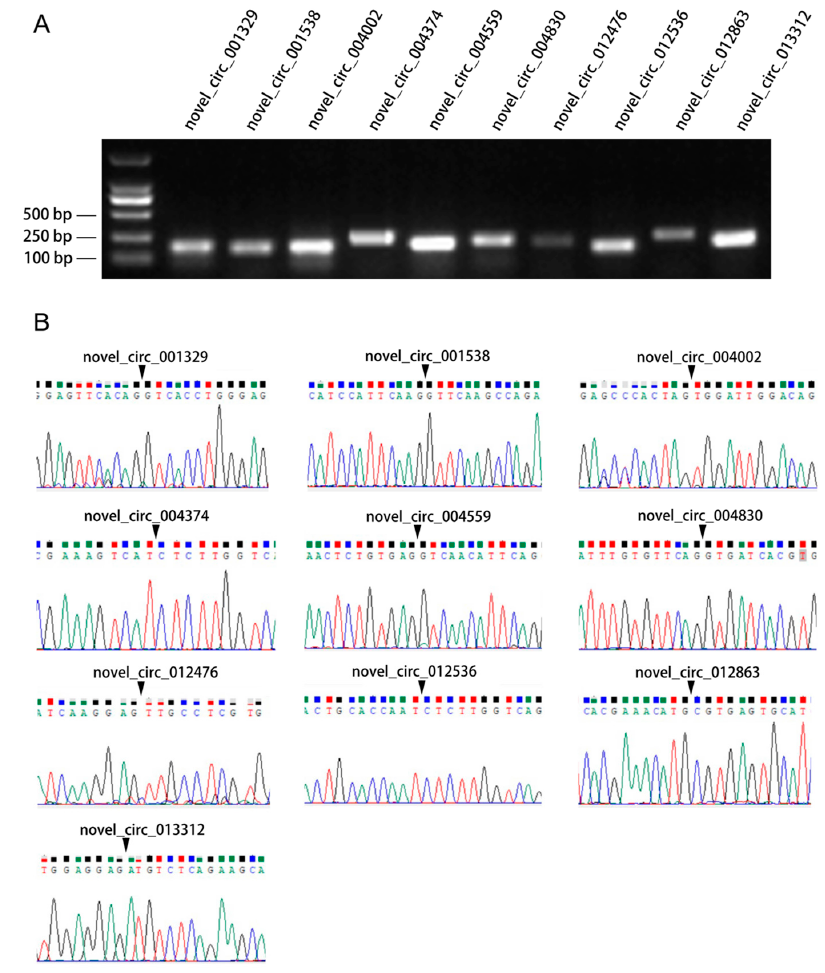
Figure 3. The agarose gel electrophoresis analysis and sequencing for novel circRNAs. ( A ) Agarose gel electrophoresis analysis demonstrating the length of circRNAs. ( B ) Sequence verification for circRNAs. Arrows show the splice junction of circRNAs.